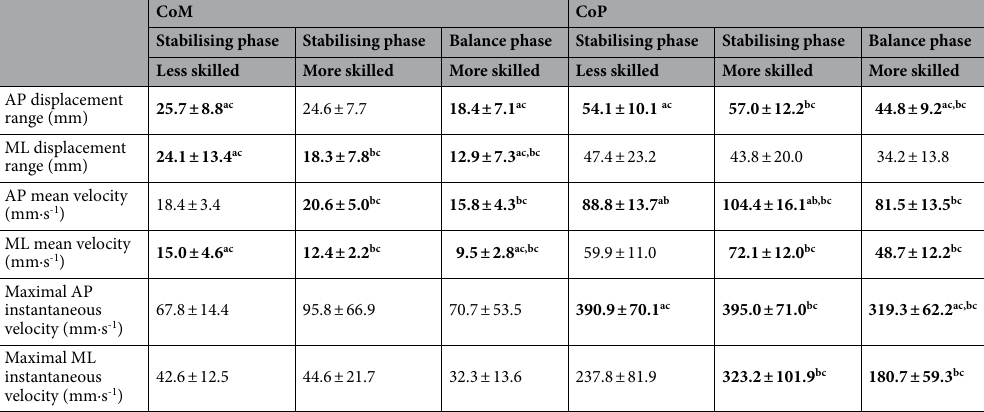
Table 1. Time domain displacement range and velocity outputs for CoM and CoP mean ± s.d. for each group. Bold values indicates a significant difference between two or more conditions ( P < 0.05). ab P < 0.05 between less and more skilled stabilising phase (independent t-test). ac P < 0.05 between less skilled stabilising phase and more skilled balance phase (independent t-test). bc P < 0.05 between more skilled stabilising phase and more skilled balance phase (paired t-test).